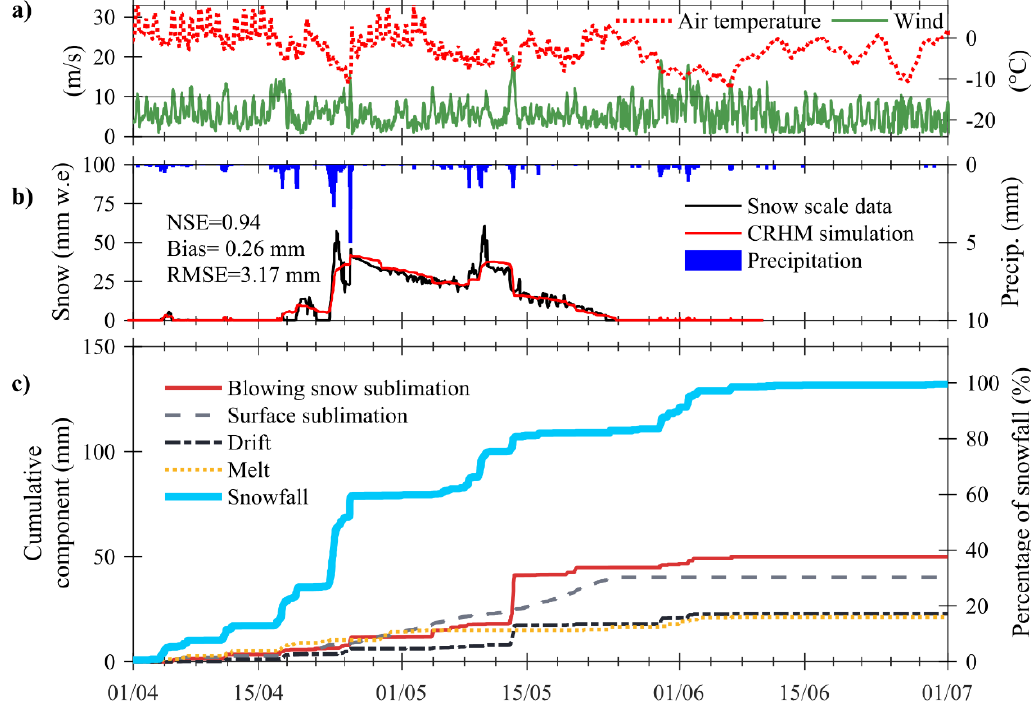
Figure 5. Measured wind speed and air temperature at La Ollita station ( a ), observed and simulated snow water equivalent (SWE) measured precipitation in the rain gauge ( b ), simulated cumulative components of the snow water balance ( c ) hourly between 1 April and 1 July 2016.